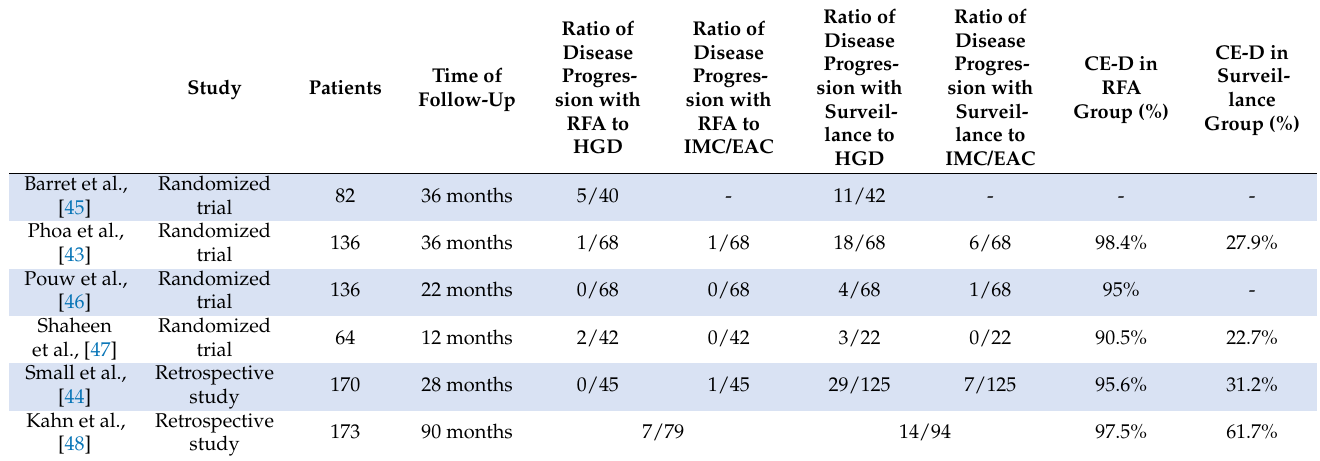
Table 2. Progression of LGD to HGD and EAC between patients treated with RFA and